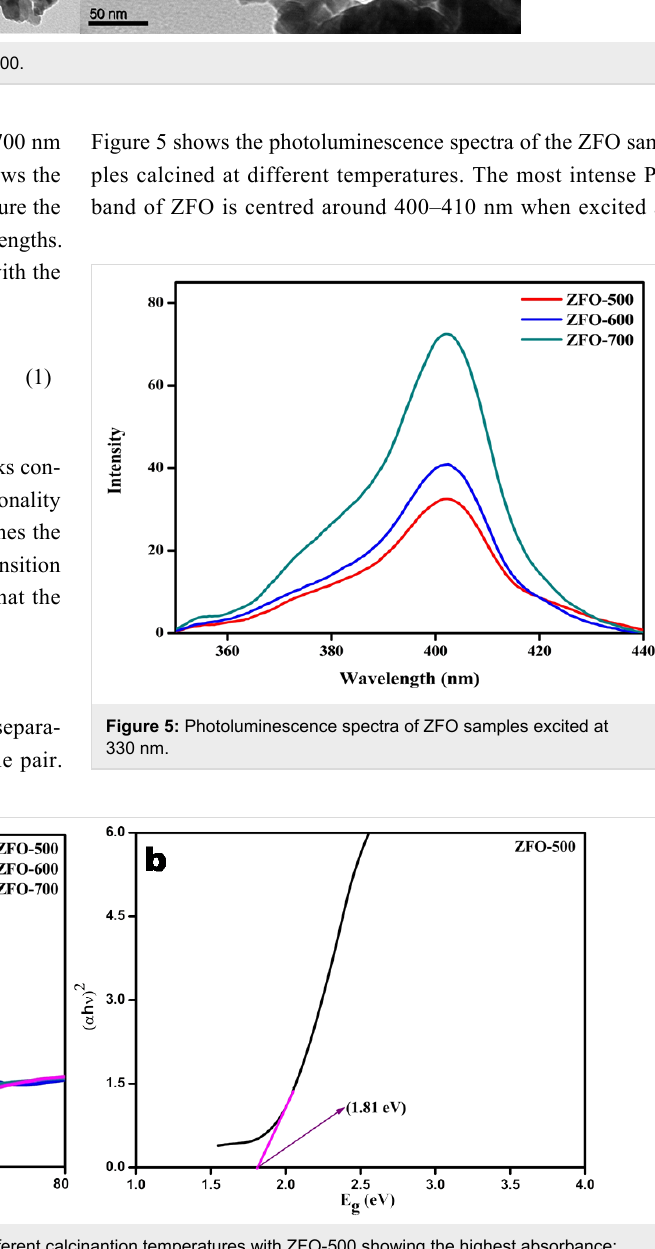
Figure 4: (a) Diffuse reflectance spectra of ZFO samples with different calcinantion temperatures with ZFO-500 showing the highest absorbance; (b) Tauc plot of ZFO-500.